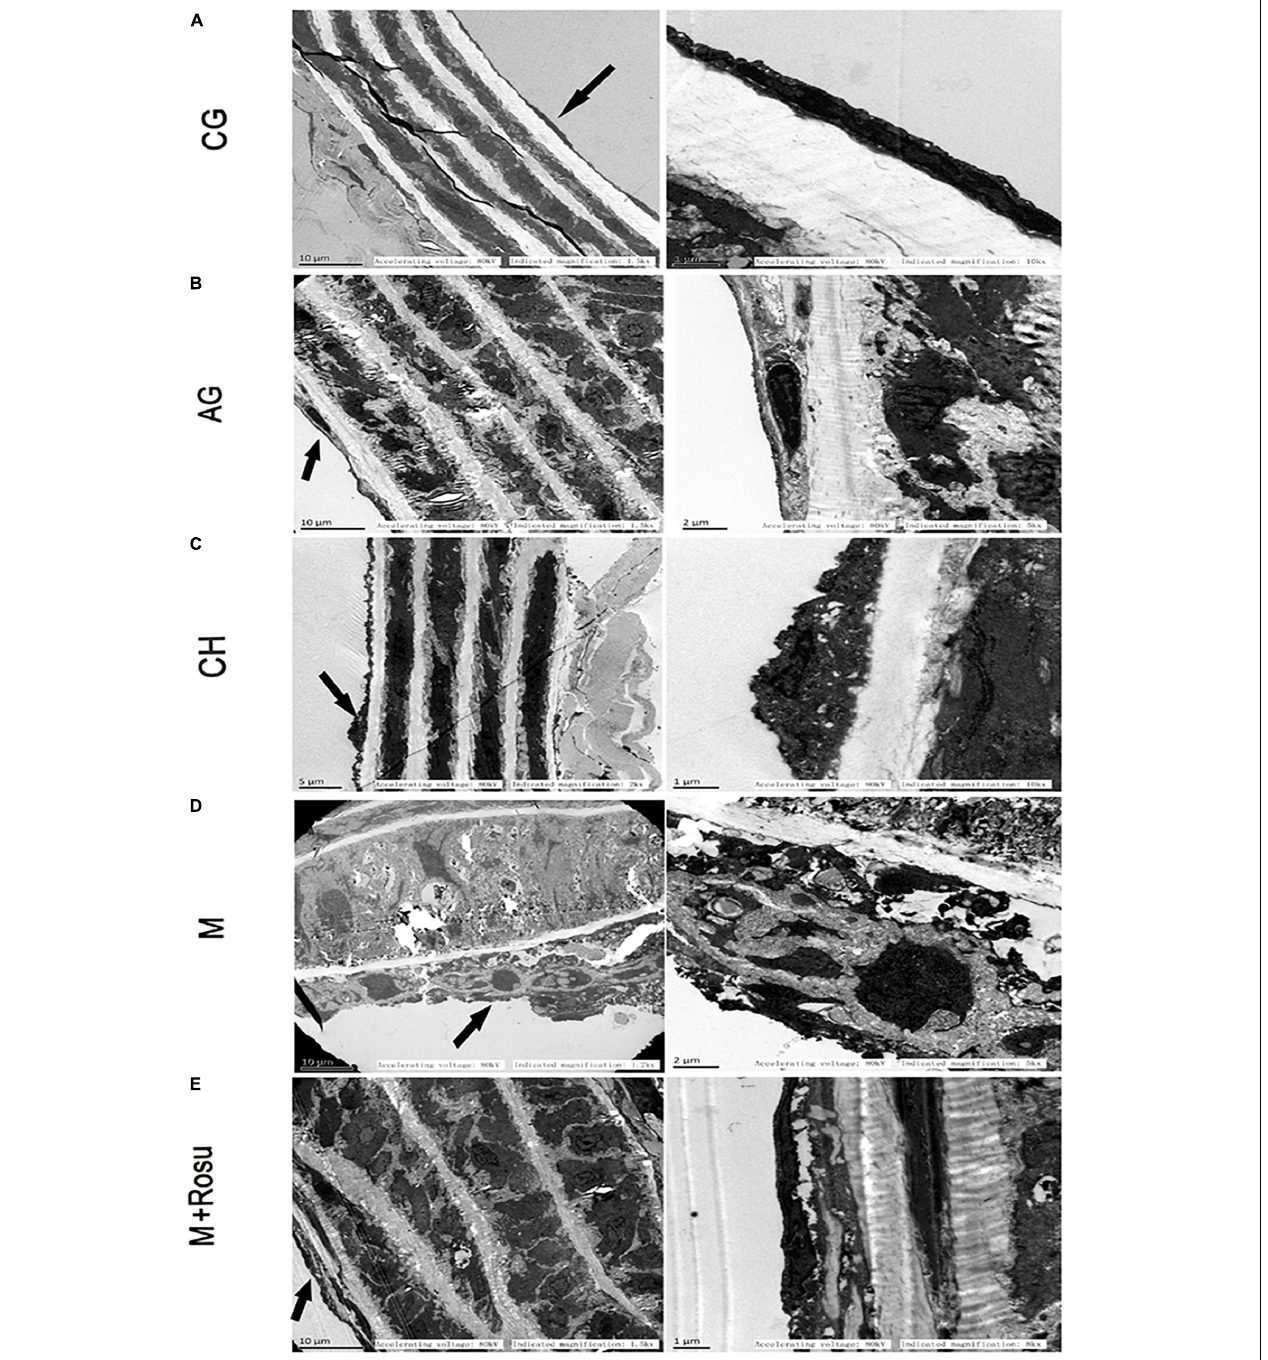
FIGURE 2 | Ultrastructural changes in arterial wall during atherosclerosis. (A) C57BL/6J+general diet. The endothelial cells of endodermis had normal nuclear and cytoplasmic contents, vascular wall lamination was clearly visible, and smooth muscle layer thickness was uniform. (B) ApoE – / – +general diet. The endothelial cells of endodermis changed slightly; vascular wall lamination was visible, while the smooth muscle layer thickened slightly. (C) C57BL/6J+high-fat diet. We can see changes in the morphology of endothelial cells and thickening of the smooth muscle layer. (D) ApoE – / – +high-fat diet. Significant morphological transformation was observed in this group, which was characterized by thickening of the smooth muscle layer, endothelial cell shape changes (from long fusiform to round and spherical shape) and nuclear pyknosis, cytoplasmic condensation, and cell volume increasing. (E) ApoE – / – +high-fat diet+Rosu. The morphology of the arterial wall in the rosuvastatin group had less damage compared with the model group; the edema of the endothelial cells was mitigated, the organelles’ structure was recovered gradually, and the nucleoli and the nuclear membrane seemed intact. The arrow shows the endothelial cell. The area indicated by the arrow is enlarged in the right column. CG, C57BL/6J+general diet; AG, ApoE – / – +general diet; CH, C57BL/6J+high-fat diet; M, ApoE – / – +high-fat diet; M+Rosu, ApoE – / – +high-fat diet+Rosu.